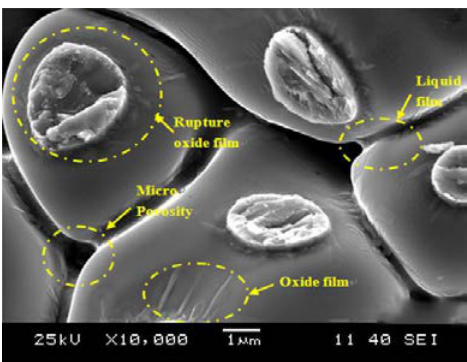
Figure 13. Typical fracture morphology cracking along the fracture splitting surface.